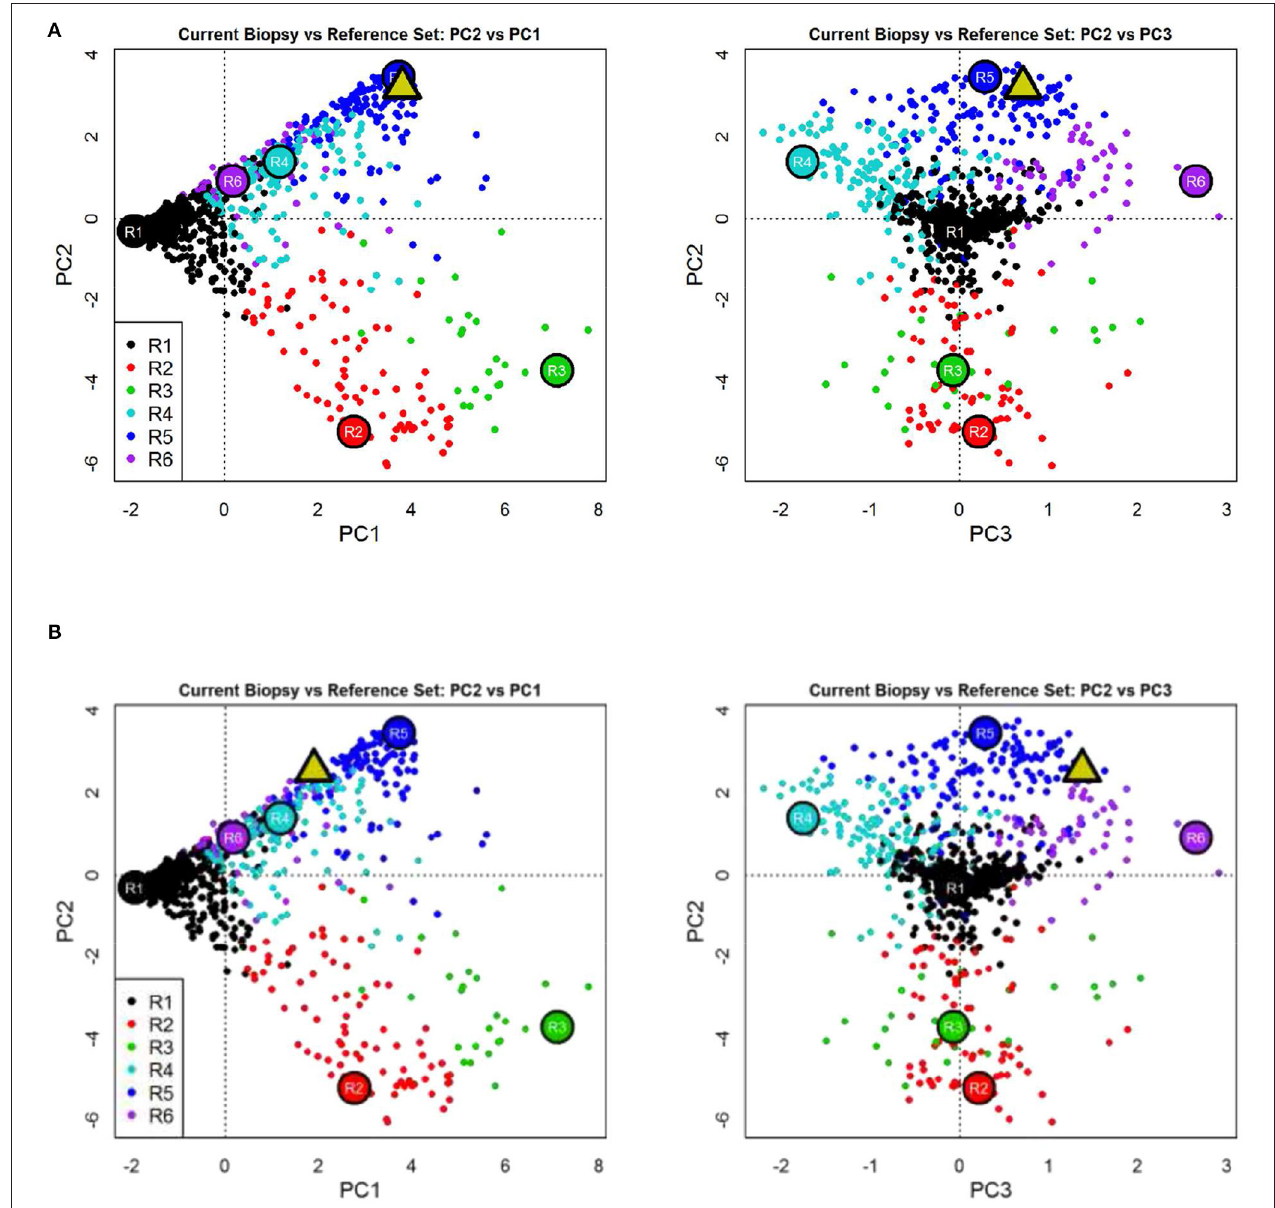
FIGURE 3 | Molecular microscope diagnostic report (MMDx) for kidney transplant biopsy before (A) and after (B) application of mesenchymal stem cells showing fully developed antibody-mediated rejection with extensive microvascular inflammation, chronic glomerulopathy, and atrophy-fibrosis molecular features.